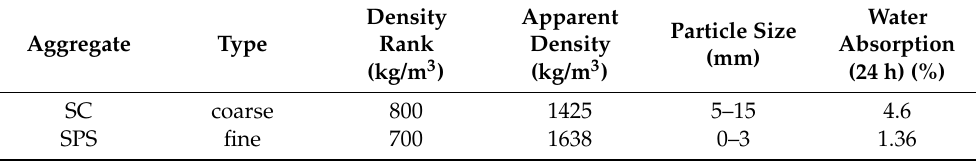
Table 1. Physical properties of the